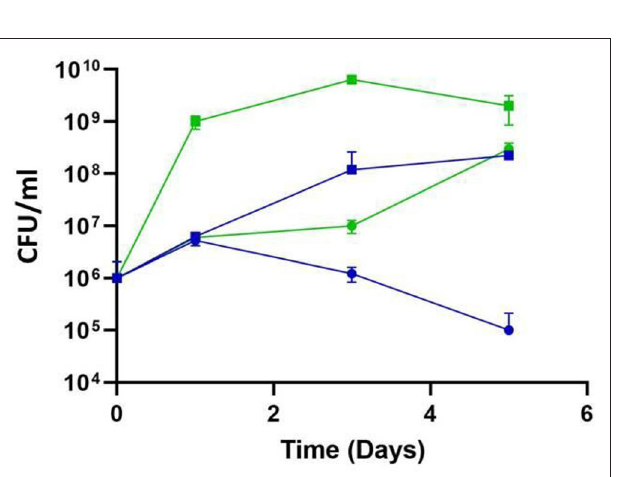
FIGURE 4 | Impact of temperature on the efficacy of phage P61 infection in TSB. L. monocytogenes cells were added to TSB broth at a final concentration of 10 6 CFU/ml and phage added at 10 8 PFU/ml (MOI = 100). Samples were incubated at 8 ◦ C (blue symbols) and 12 ◦ C (green symbols) and L. monocytogenes enumerated daily. Squares represent untreated samples; circles represent phage-treated samples.